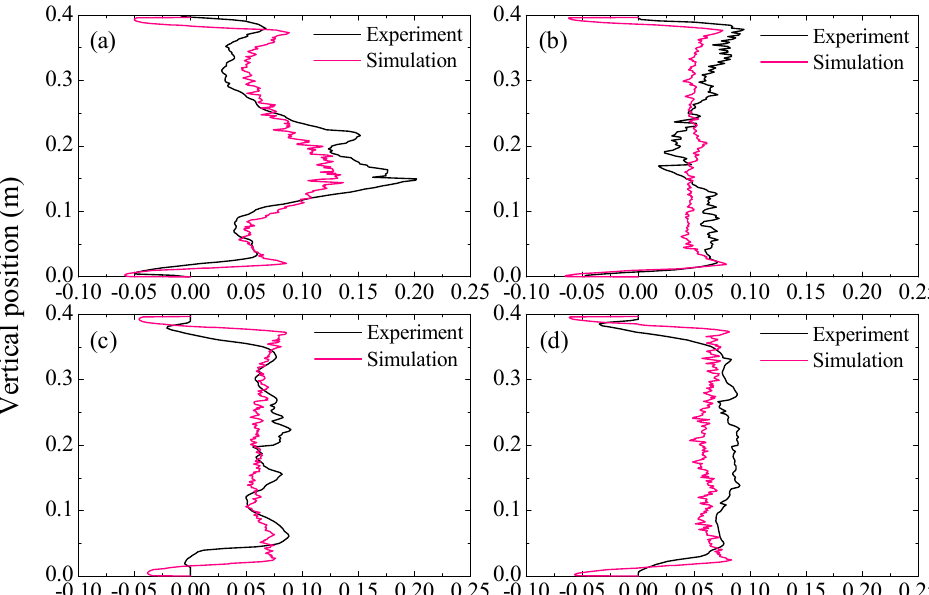
Figure 16. Comparison of the measured horizontal velocity profiles with the numerical simulation data: ( a ) without perforated plate (middle plane), ( b ) without perforated plate (side plane), ( c ) with perforated plate (middle plane), and ( d ) with perforated plate (side plane).